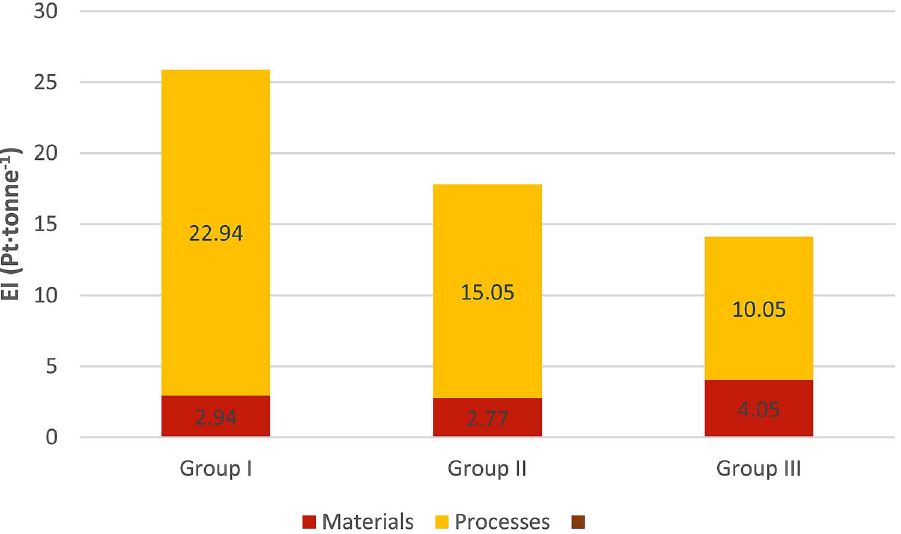
Figure 5. The structure of the total environmental impact as per the biomass